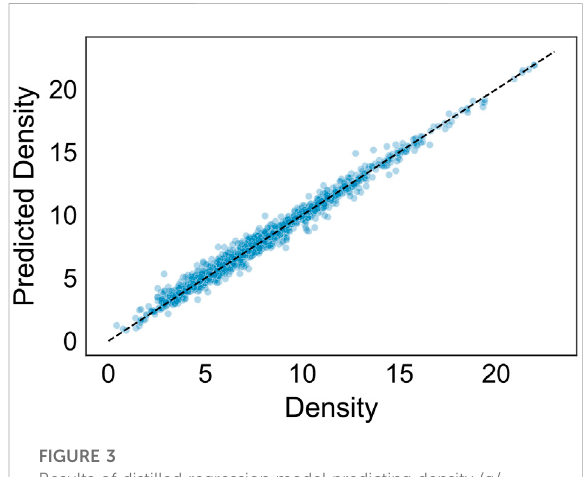
FIGURE 3 Results of distilled regression model predicting density (g/ cm 3 ). The prediction accuracy ( R 2 ) is approximately